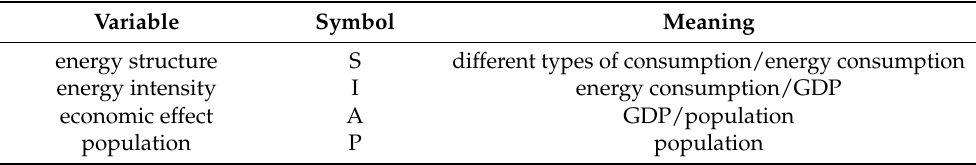
Table 2. Meaning of the variables in LMDI